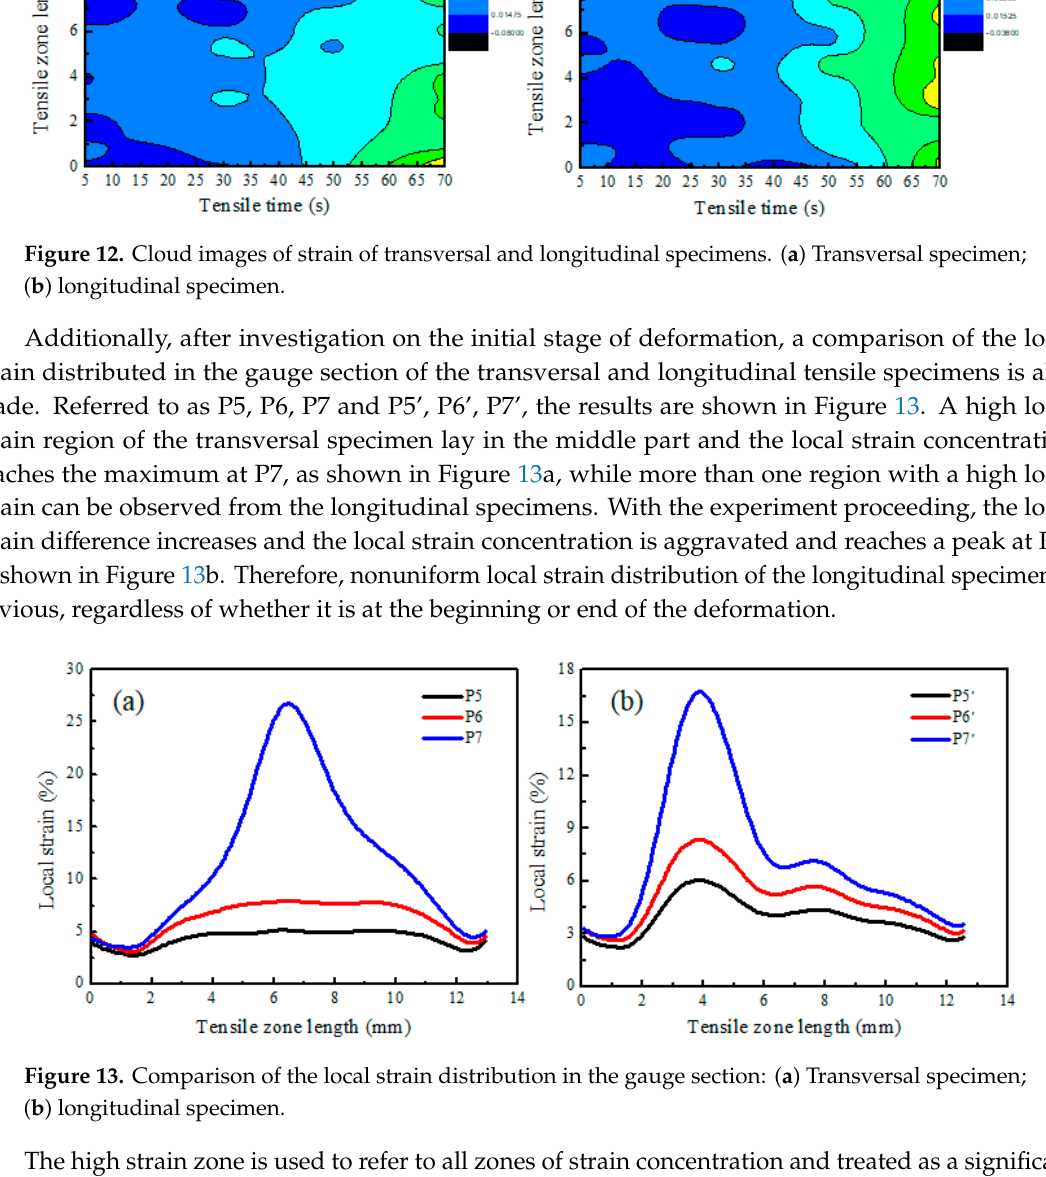
Figure 14. Strain distribution condition in high strain zones before fracture. ( a ) Transversal specimen; ( b ) longitudinal specimen. Based on the strain distribution condition, high strain zones can be divided into six high strain gradients and a comparison of the duration of high strain gradients is made to reveal the differences between the transversal and longitudinal tensile specimens. The results are shown in Figure 15. It can be seen from Figure 15, that the duration in the high strain zone (from stage I to VI) of the transversal specimen is longer than that of the longitudinal specimen. Furthermore, as high strain varied from stage VI to I (close to fracture), the duration gap between the transversal and longitudinal specimens gradually expands, suggesting that in high strain zones, the transversal specimen performed better, and the higher strain stage the tensile test experiences, the more remarkable the duration superiority of the transversal specimen.